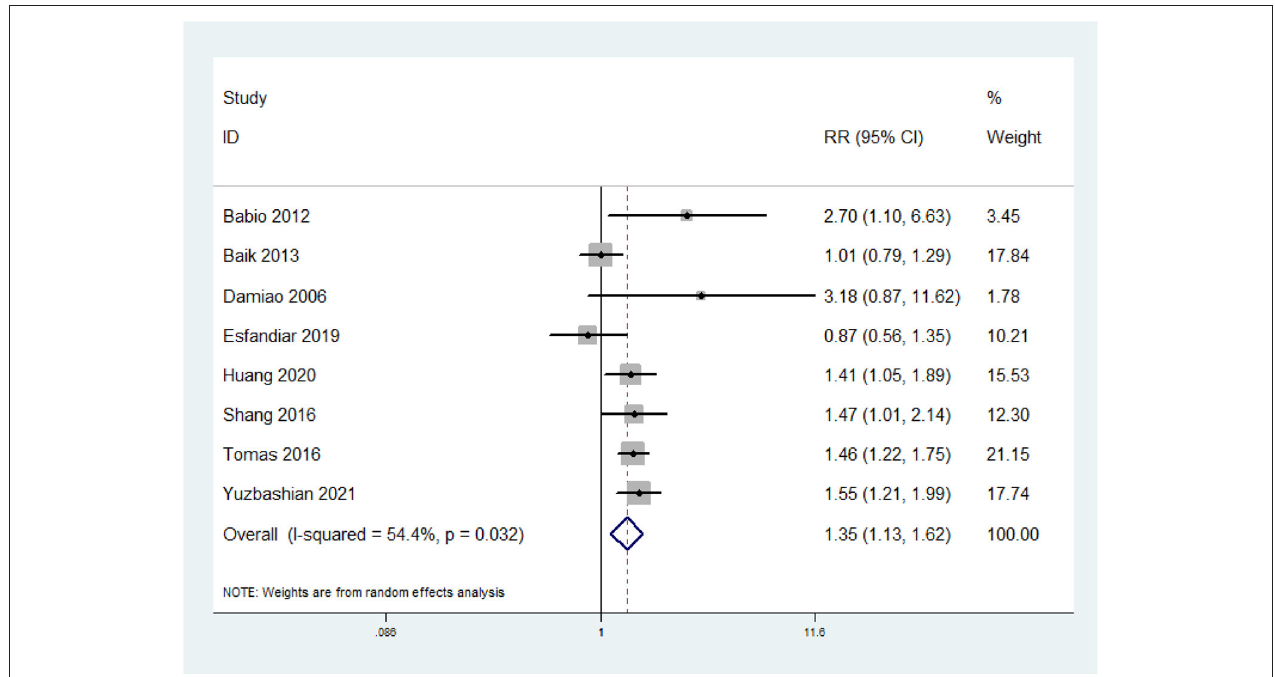
FIGURE 2 | Forest plot of meta-analysis: overall multi-variable adjusted RR of MetS for the highest vs. lowest category of red meat consumption.